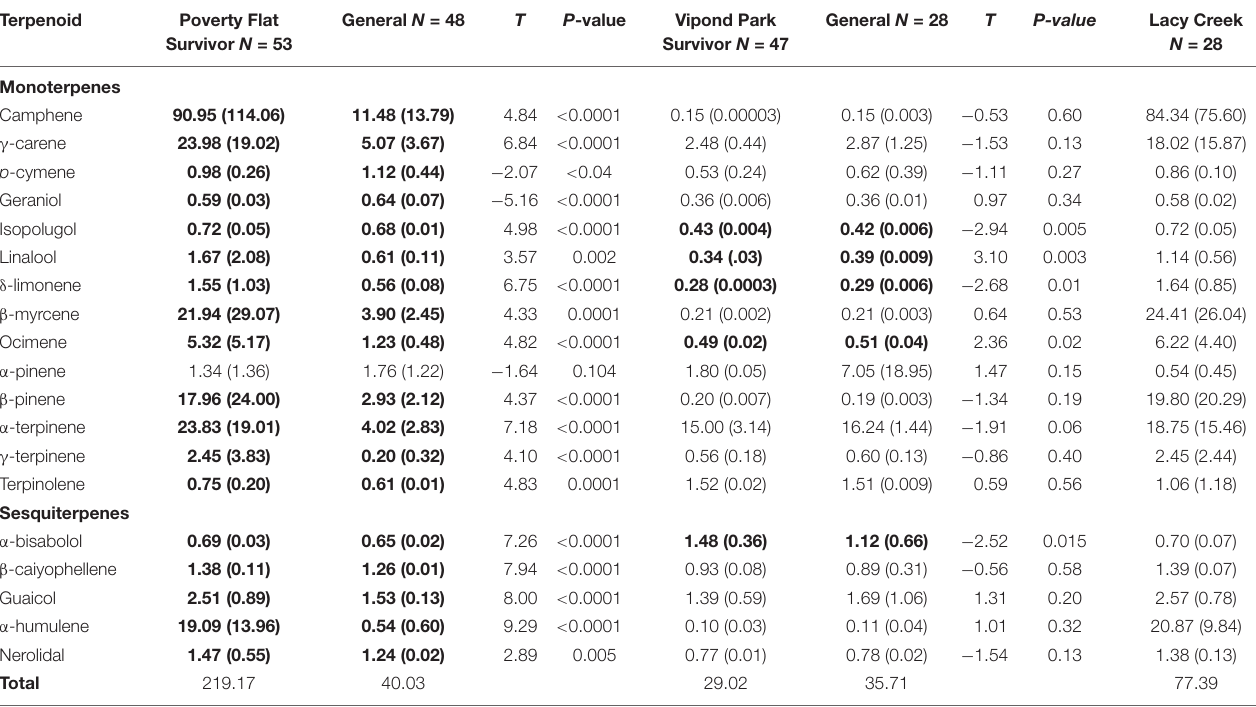
TABLE 4 | Comparisons of mean (SD) of terpenoid concentrations (mg/g) of survivor and general Pinus albicaulis at two sites affected by a recent Dendroctonus ponderosae outbreak and statistics for trees at a third site unaffected by the outbreak. Terpenoid Poverty Flat General N = Survivor N = 53